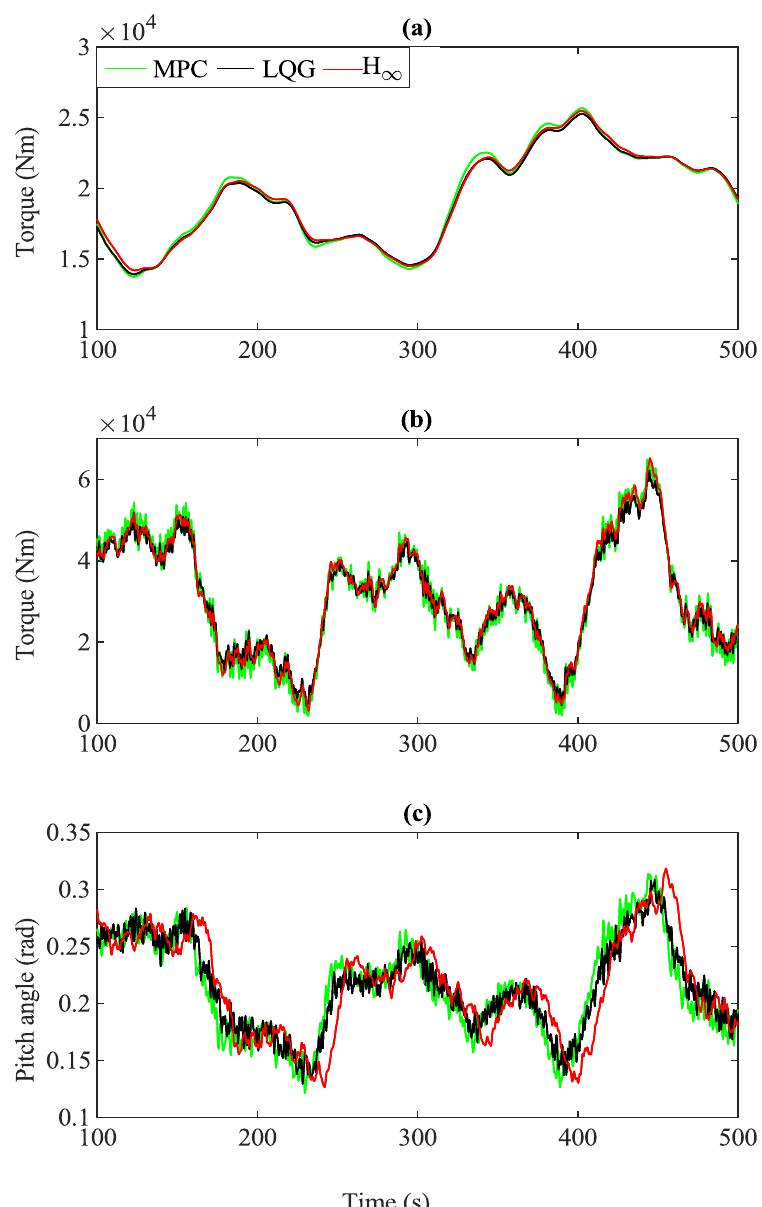
Figure 13. Time responses of torque and pitch angle demand (control input) in mode 1 and 2 and mode 3, respectively: MPC, LQG, and H ∞ based on Bladed linearization model; ( a ) mode 1, ( b ) mode 2, ( c ) mode